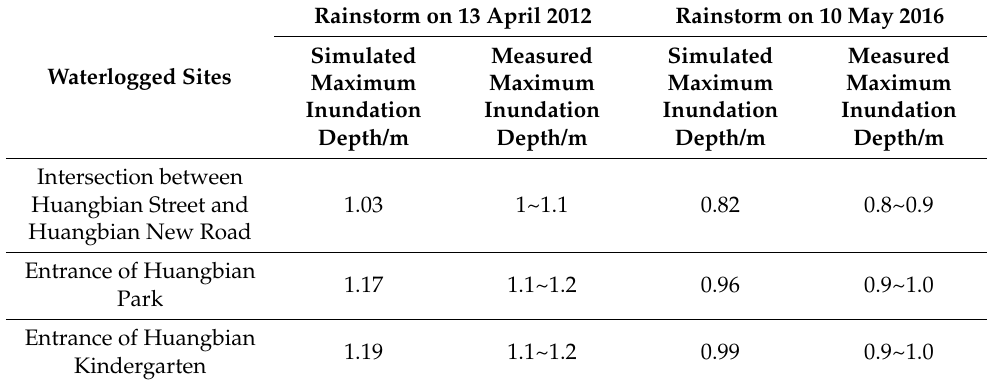
Table 1. Model calibration and